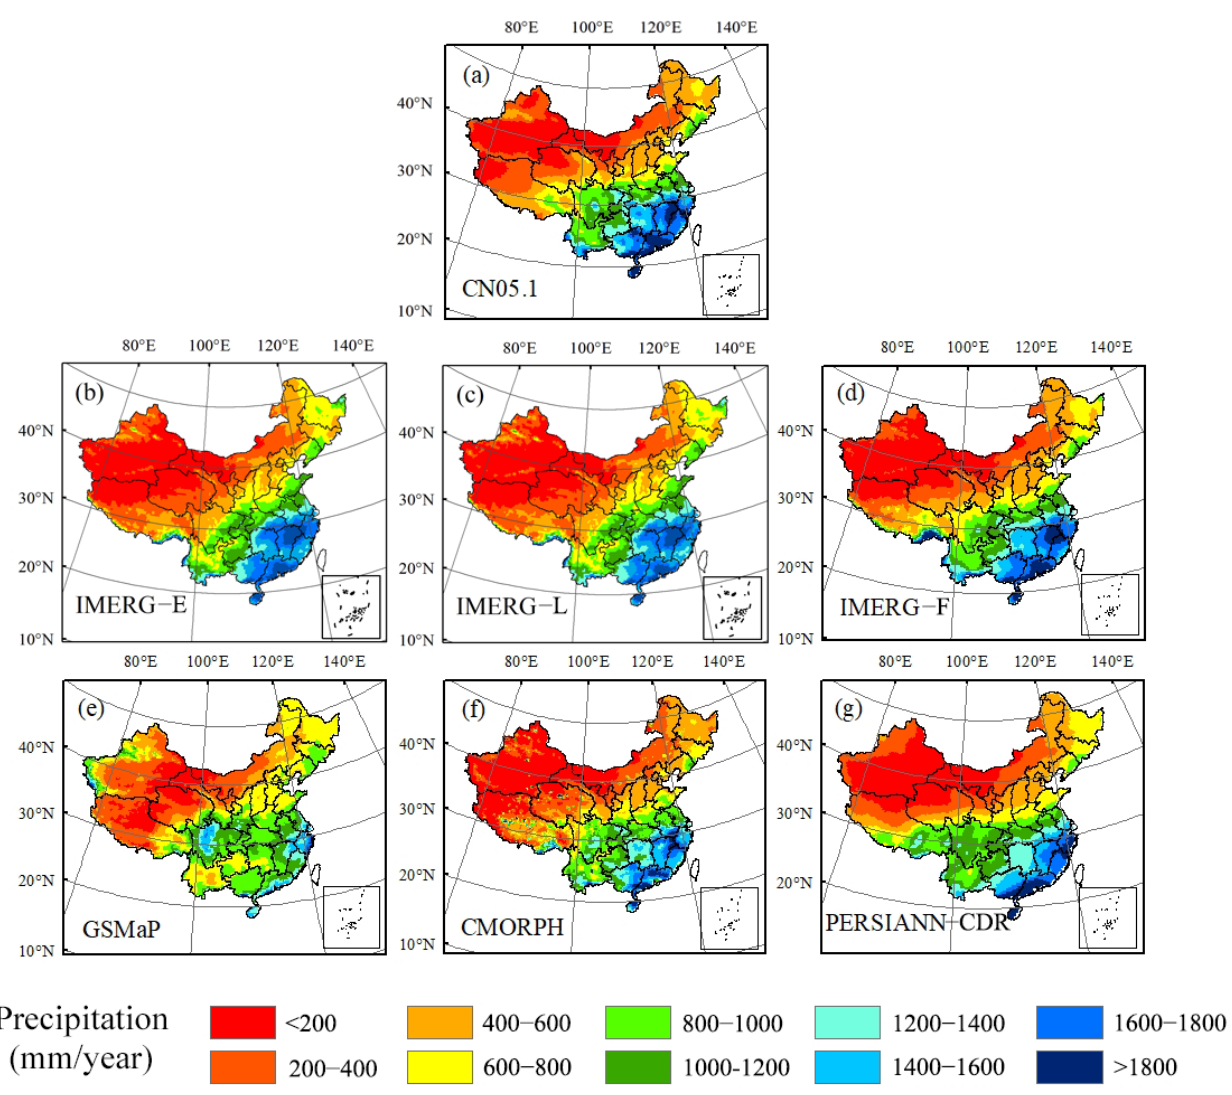
Figure 8. Comparisons of spatial distributions of annual precipitation between six satellite products and ground interpolation product (CN05.1): ( a ) CN05.1, ( b ) IMERG – E, ( c ) IMERG – L, ( d ) IMERG –